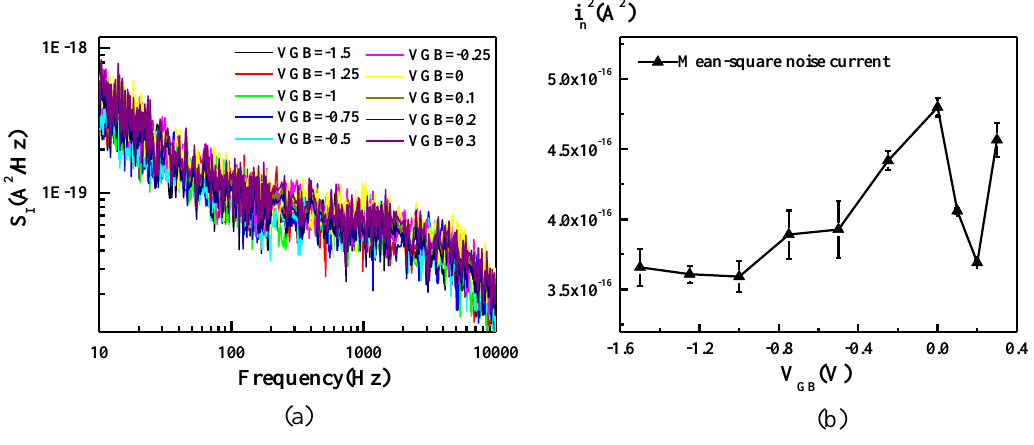
Figure 8. Noise measured with various V noise power spectral density (b) mean-square noise current integrated from 10 to 10